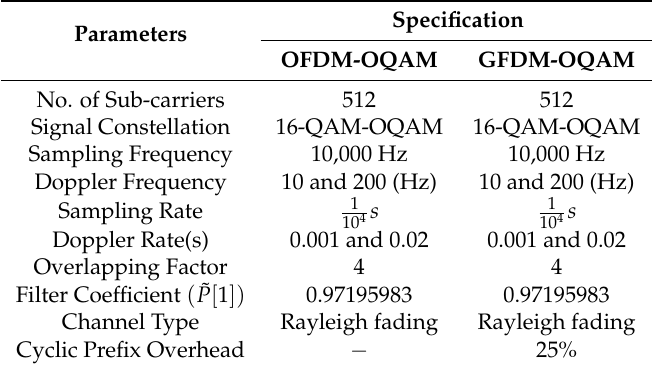
Table 6. Simulation parameters for FBMC-OQAM waveforms.